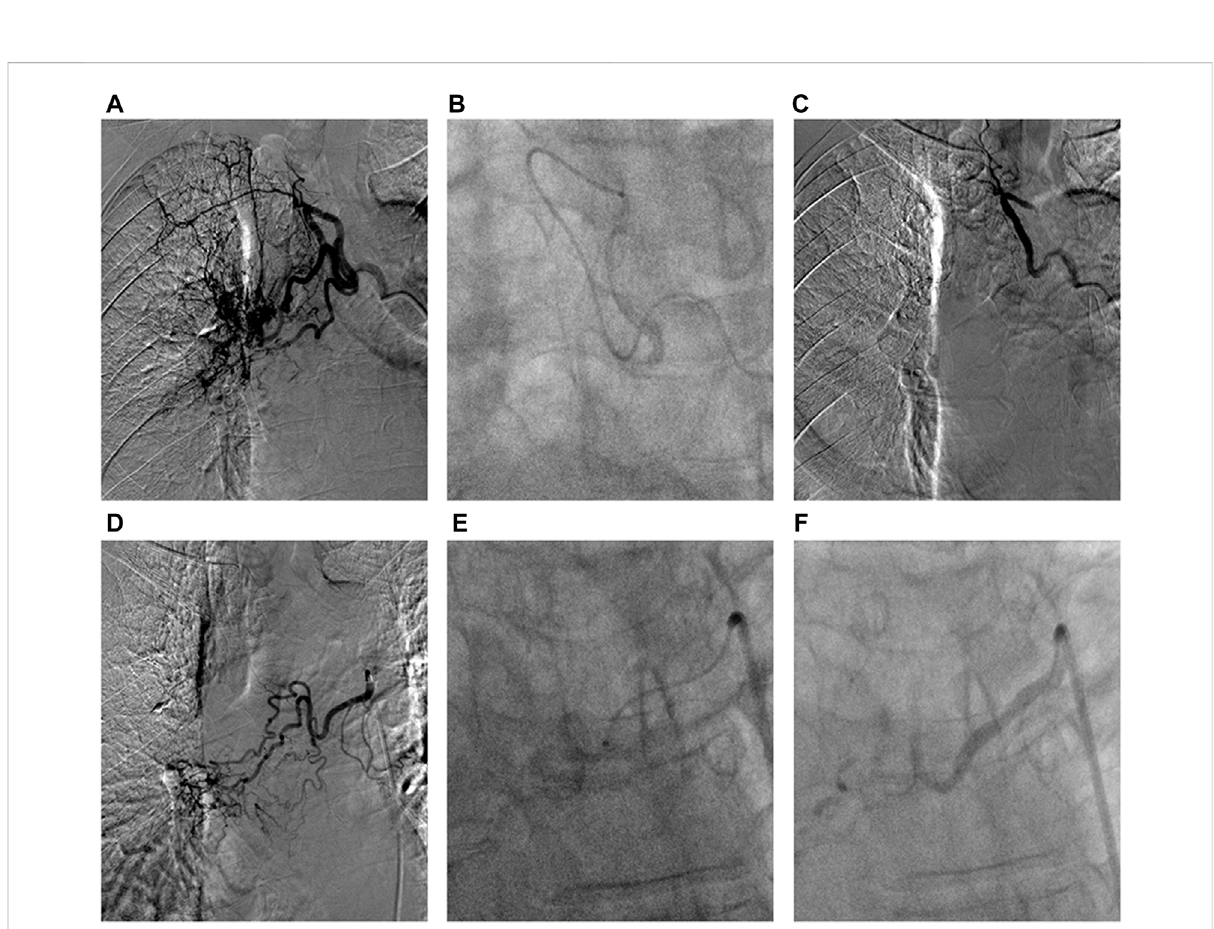
FIGURE 1 The DEB-BACE procedure in advanced squamous cell carcinoma of the right lung. (A) Arteriography showed the intercostal bronchial artery was one main feeding artery of tumor mass; (B) The super-selective catheterization with a coaxial microcatheter system (1.98F) was performed to avoid the intercostal artery, and then infuse vinorelbine loaded beads; (C) There was no obvious tumor staining after successful embolization; (D) Onerightbronchialarterywasconsideredastheotherfeedingarteryoftumor; (E) Thesuper-selectivecatheterizationwasperformedtoinfuse vinorelbine loaded beads; (F) During second angiography, the distal arterial branches of the right bronchial artery was not observed after successful